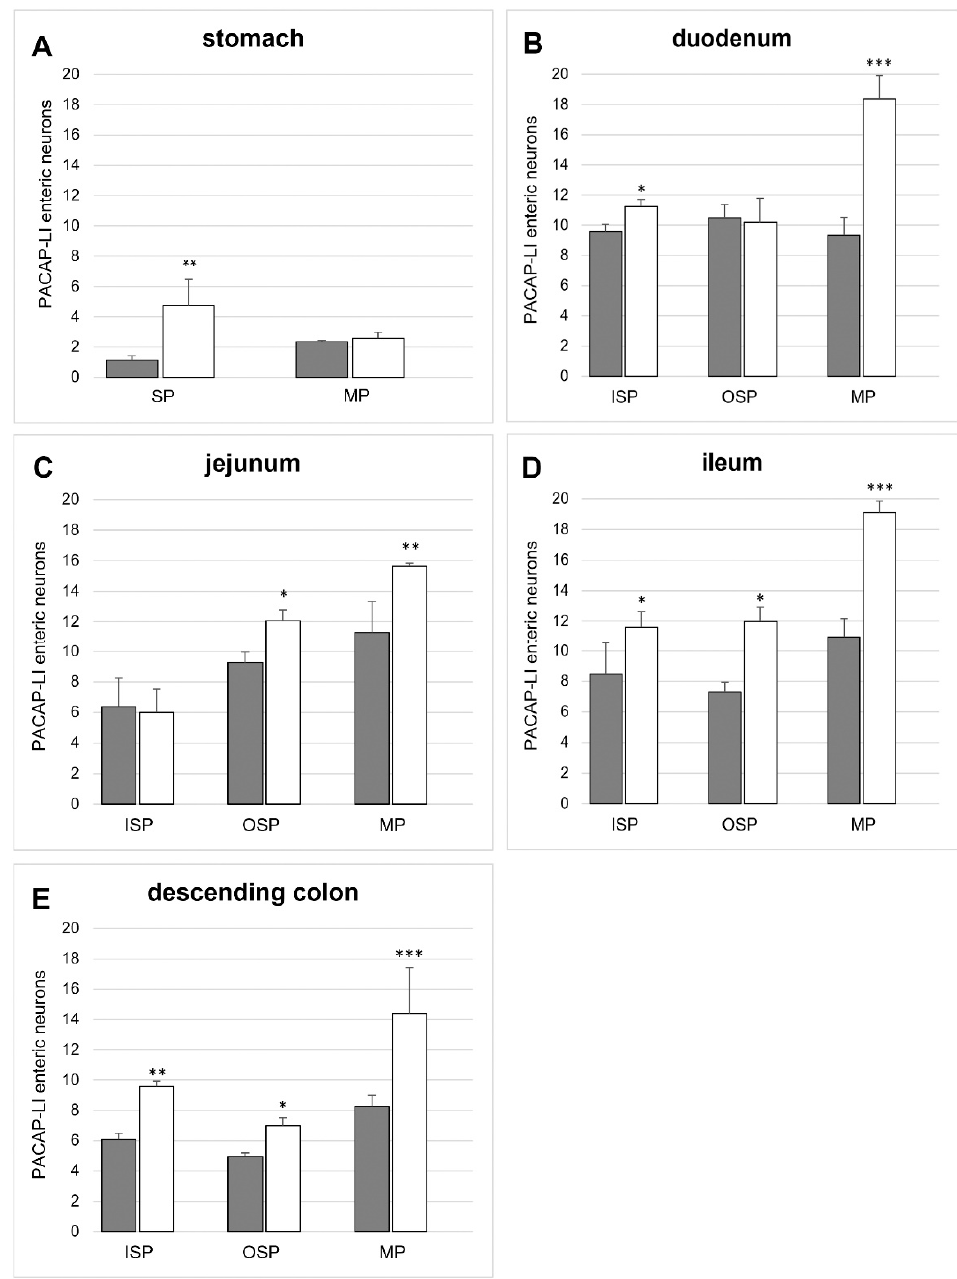
Figure 2. Histograms showing the percentage of PACAP- LI neurons in the wall of selected parts of the gastrointestinal tract in control (grey bars) and diabetic pigs (white bars). ( A )—PACAP-LI enteric neurons in the corpus of the stomach, ( B )—PACAP-LI enteric neurons in the duodenum, ( C )—PACAP-LI enteric neurons in the jejunum, ( D )—PACAP-LI enteric neurons in the ileum, ( E )—PACAP-LI enteric neurons in the descending colon. Significant differences were assessed with Student’s t-test for independent samples (* p < 0.05, ** p < 0.01, and *** p < 0.001).